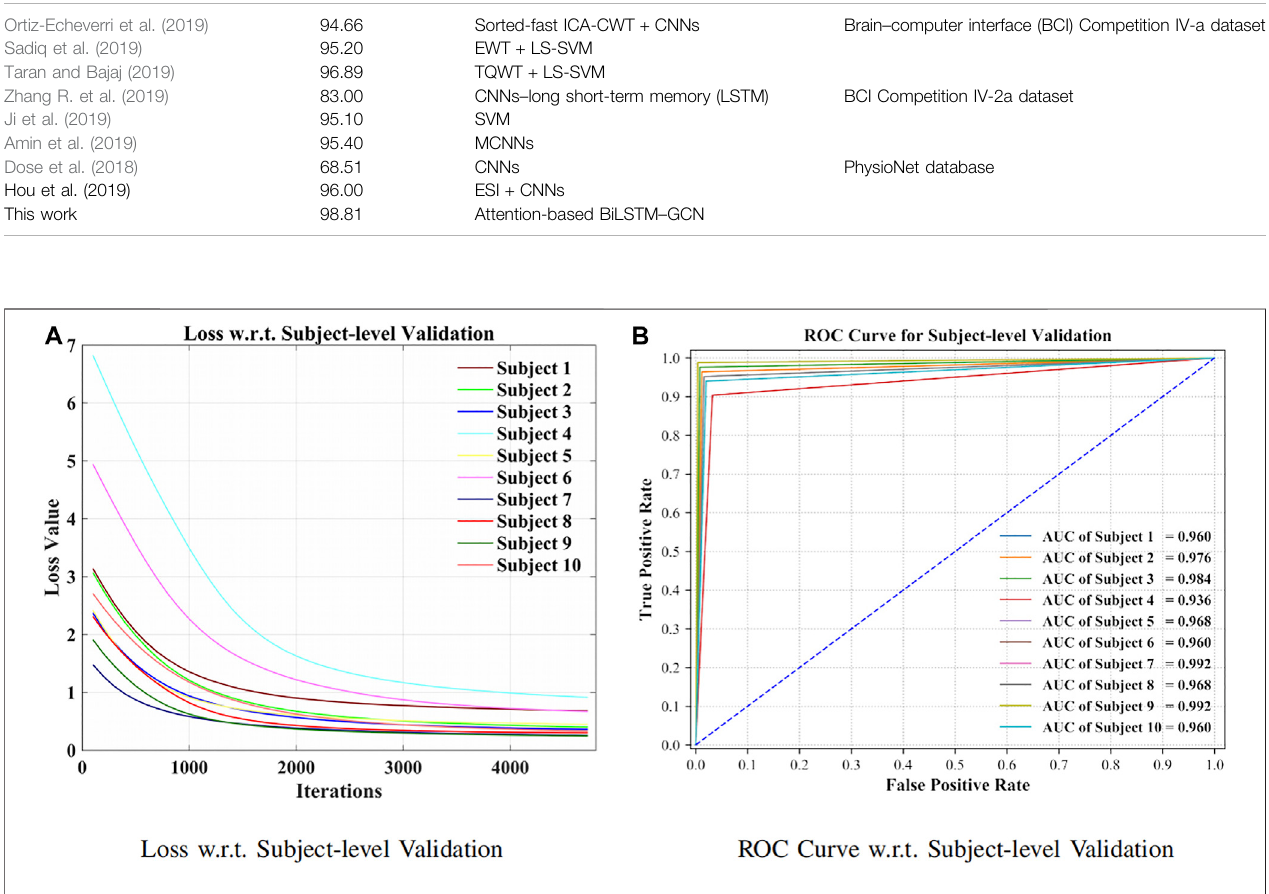
FIGURE 7 | Loss and ROC curve for subject-level evaluation. (A) Loss w.r.t. subject-level validation. (B) ROC curve w.r.t. subject-level